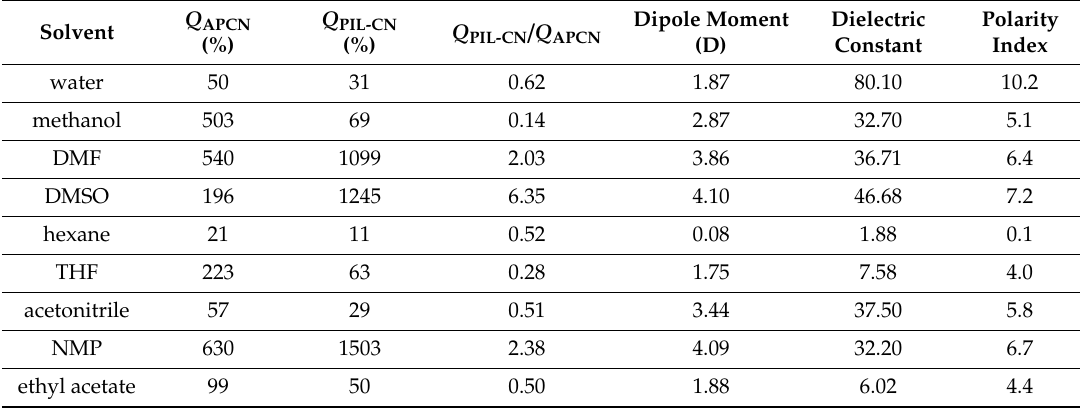
Figure 6. The swelling degrees as a function of time of the PVIm- l -PTHF-57 (blue) and PVImMe- l -PTHF-57 poly(ionic liquid) (red) conetworks as a function of time in different solvents: hexane ( A ), THF ( B ), ethyl acetate ( C ), methanol ( D ), acetonitrile ( E ), DMF ( F ), NMP ( G ), DMSO ( H ), and distilled water ( I ). Table 2. The equilibrium swelling degrees of the PVIm -l- PTHF-57 ( Q APCN ) and PVImMe -l- PTHF-57 ( Q PIL-CN ) conetworks, the ratio of their swelling degrees ( Q PIL-CN / Q APCN ), and the dipole moment, dielectric constant, and polarity index of the investigated